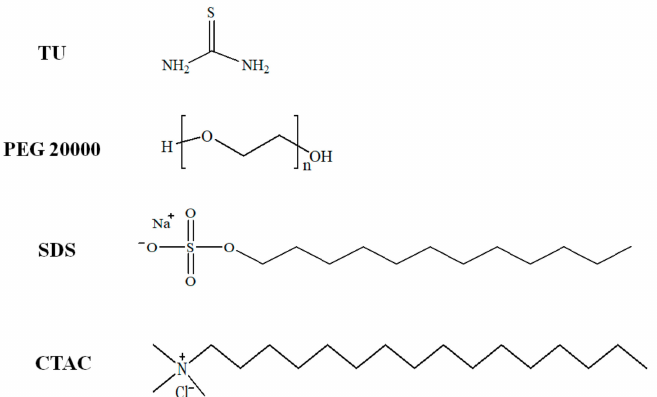
Figure 1. Simple molecular structure of additives.